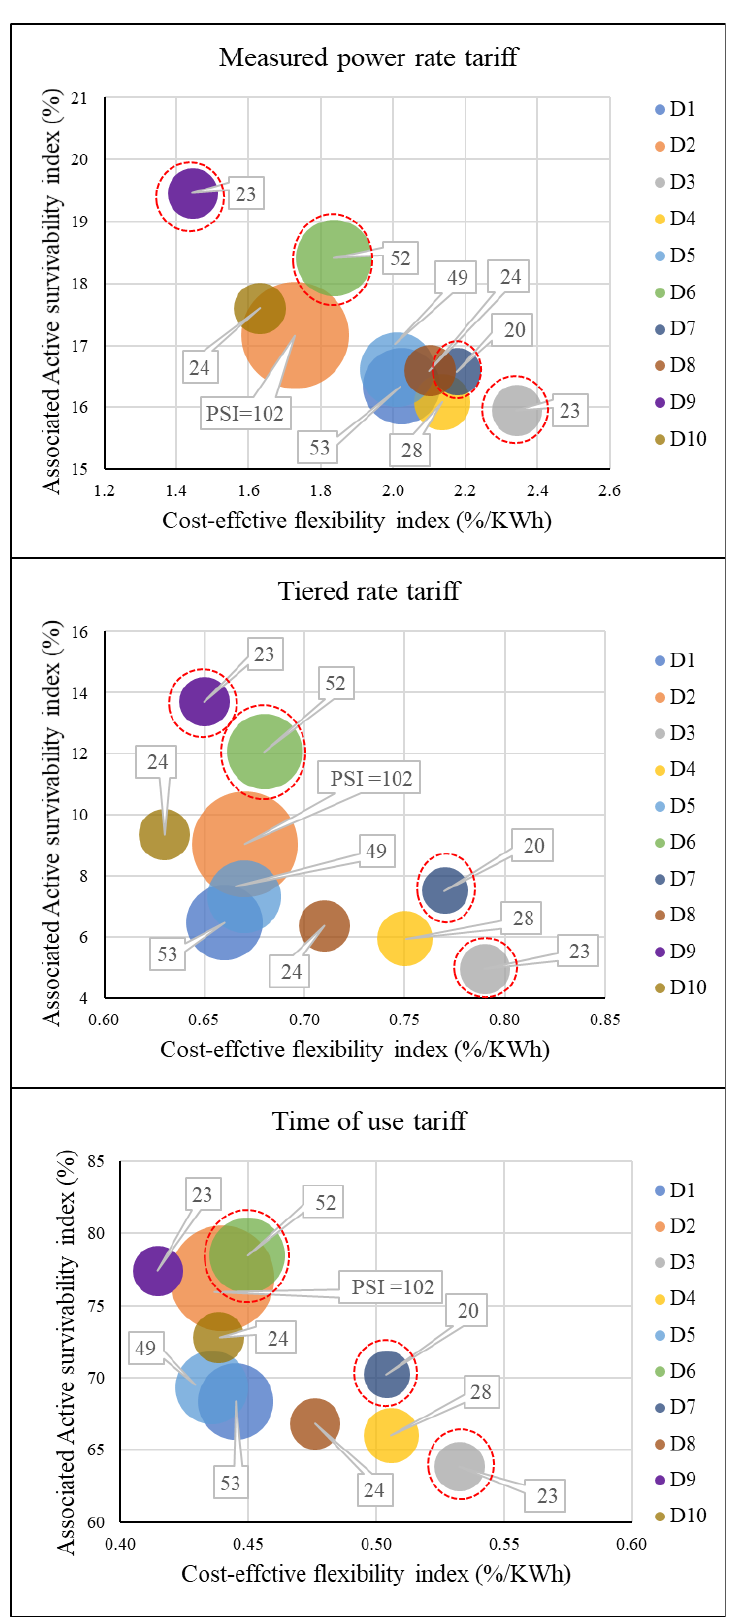
Figure 13. The trade-offs between cost-effective energy flexibility and survivability. The bubble size indicates the relative value of passive survivability